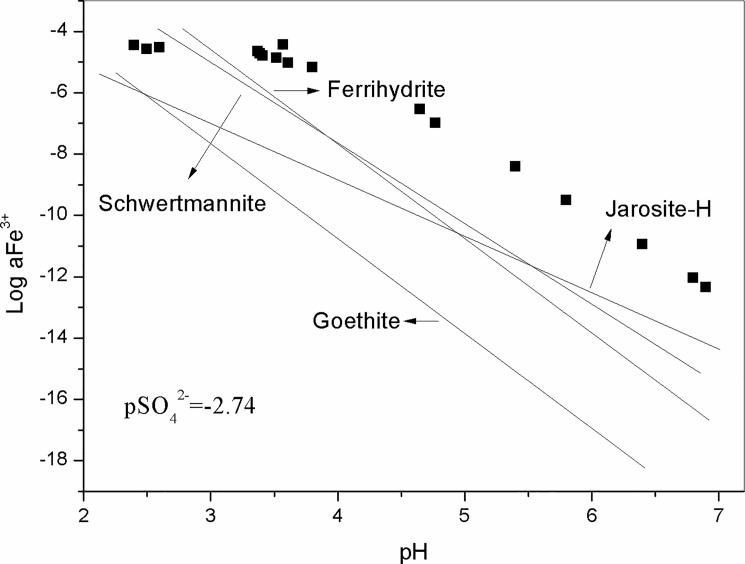
Activity of Fe3+ relative to pH (Solubility lines are as follows: goethite (log aFe3+ = 1.4-3pH), ferrihydrite (logaFe3+ = 4.3-3pH), and schwertmannite (log aFe3+ = 2.83–2.6pH), jarosite (log aFe3+ = -2.5–1.67 pH)).